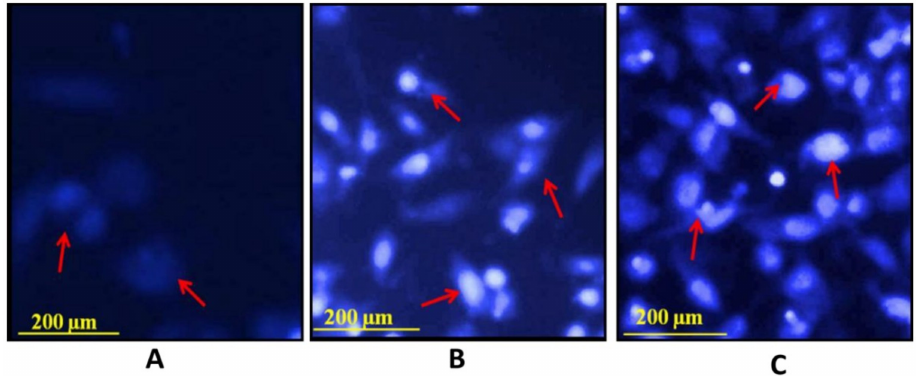
Figure 8. Effect of EP on nuclear damages in MCF-7 cells were observed with Hoechst 33258 staining under fluorescence microscopy. ( A ) Control (untreated), ( B ) EP (40 µ g/mL) and ( C ) EP (80 µ g/mL) for 24